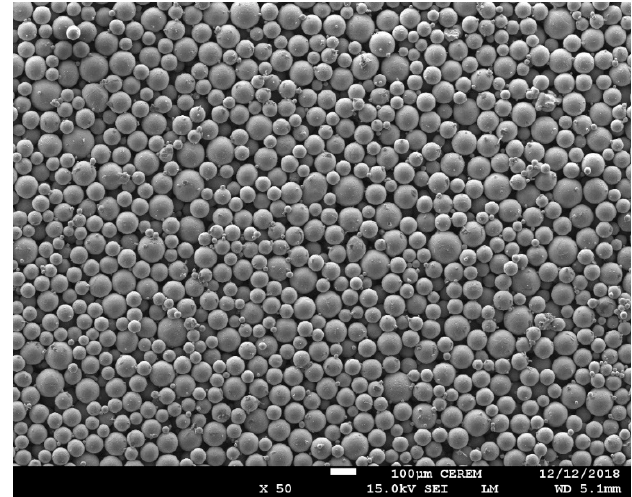
Figure 1. Model dimensions and different support configurations for electron beam melting (EBM) build parts.